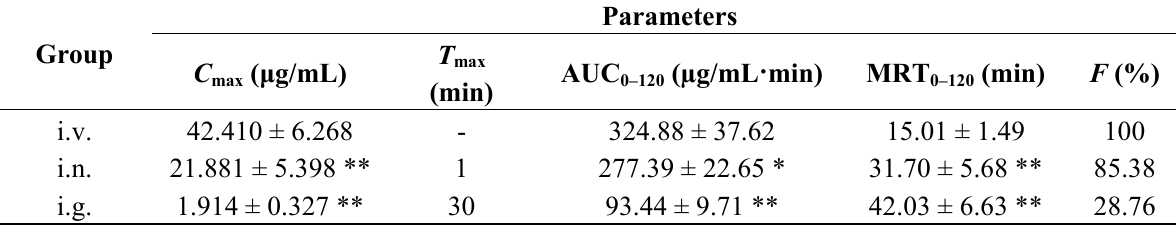
Figure 5. Non-compartmental analysis of pharmacokinetic data was performed by Kinetica 4.4 as shown in Table 2. The relative brain targeted coefficient was R e, R e = AUC /AUC × brain (i.n./i.g.) brain (i.v.) 100%. The brain/blood drug ratio was T e, T e = AUC /AUC × 100%. So the drug target index brain blood was DTI, DTI = T e / T e . The results showed that the average value of C in brain (i.n. /i.g.) (i.v) max